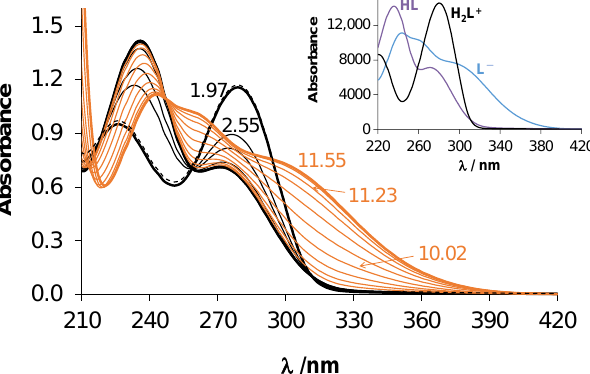
Figure 5. Absorbance spectra of MOLNU recorded in the pH range between 1.97 and 11.55 (solid lines) and after back-acidification at pH 1.97 (dotted line), inset shows computed individual molar spectra of the compound in different protonation states [ c MOLNU = 40 µM; I = 0.1 M (KCl), t = 25 °C].